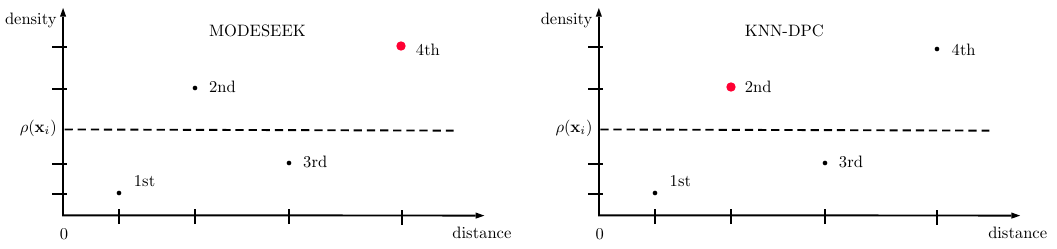
Figure 1. Illustration of the difference between the neighbor search strategies of MODESEEK and M - KNN - DPC . MODESEEK retains, among the current sample x i and its K nearest neighbors, the one with the highest density (here the fourth NN), whereas M - KNN - DPC retains the closest with higher density than the current sample (here the second NN).